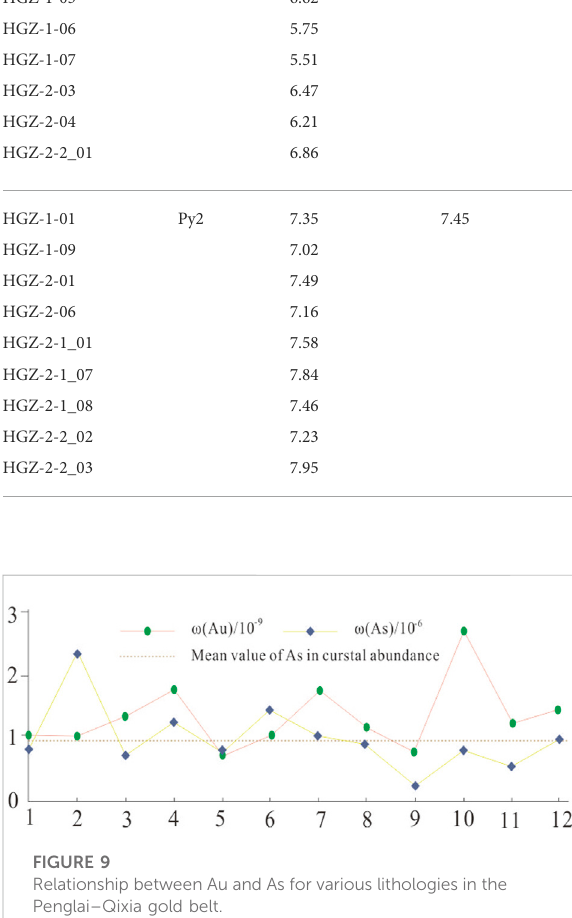
FIGURE 9 Relationship between Au and As for various lithologies in the Penglai – Qixia gold